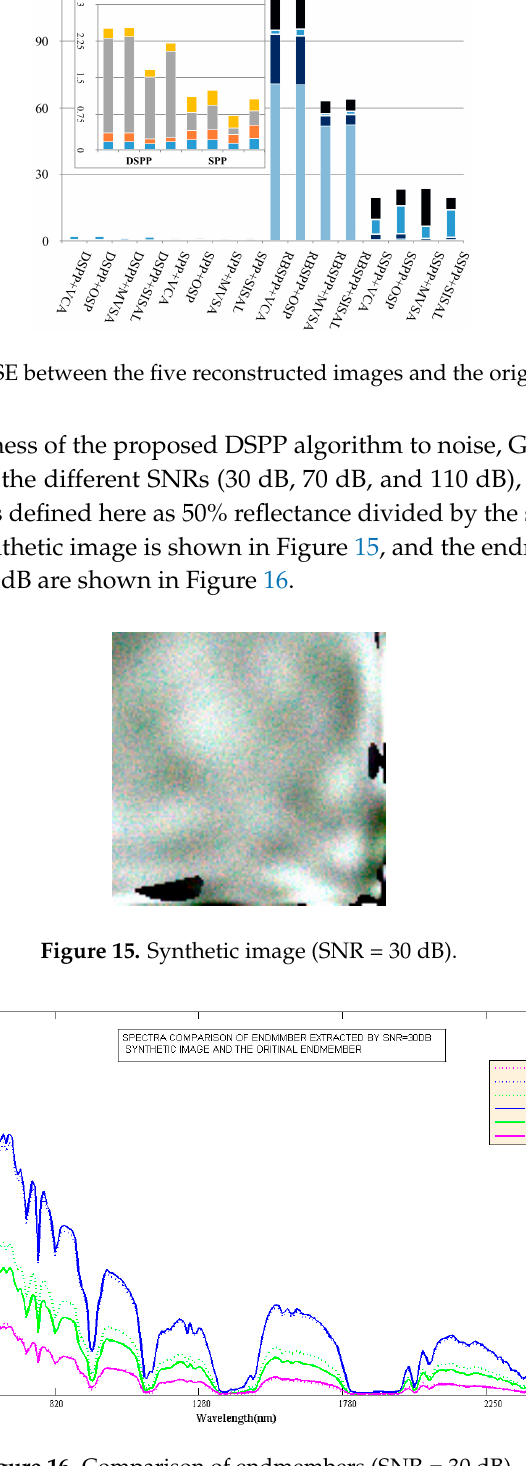
Figure 16. Comparison of endmembers (SNR = 30 dB) .